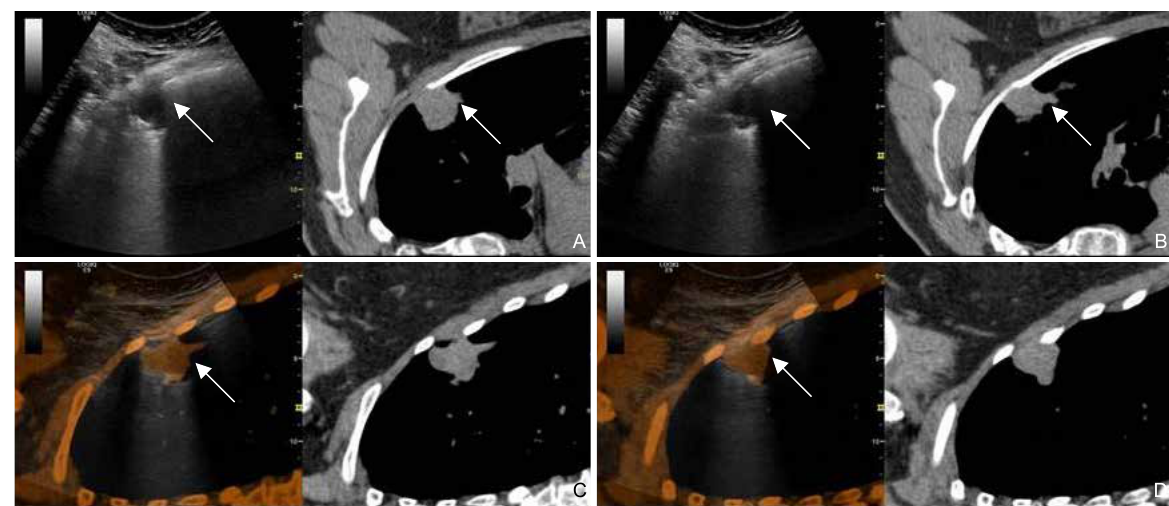
Figure 5 The fusion image of CT (right) and US (left) shows the lung metastasis lesion and evaluates the part of tumor covered with lung (arrow) (A and B). The overlap display mode of fusion image (C and